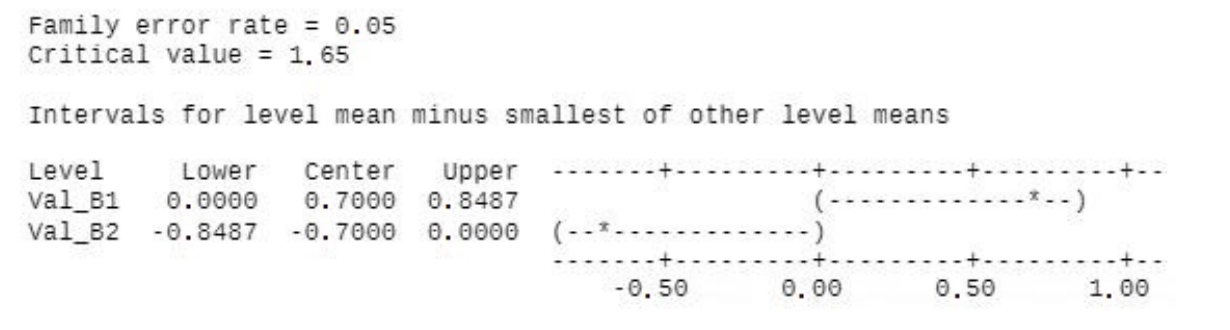
Figure 7. Hsu’s MCB method creates a confidence interval for the difference between each level mean and the best of the remaining level means. There is a statistically significant difference between groups B1 and B2. *—the OUTLIER- an unusually large or small observation. Values beyond the whiskers are outliers.